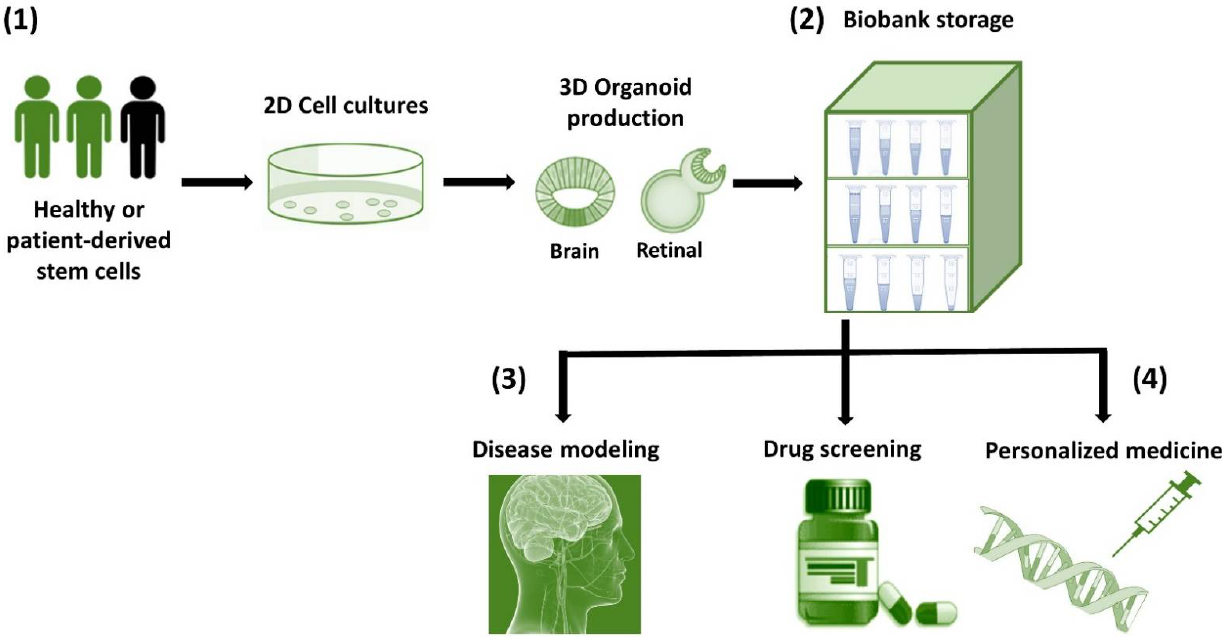
Figure 1. Schematic representation of the workflow from the production of brain and retinal organoids to their possible conservation/biobanking and potential applications. (1) Healthy or patient-derived stem cells differentiate and produce brain and retinal 3D organoids. (2) Biobanking, whereby samples obtained from patients can be used to store patient-generated organoids as a resource for future research. (3) Disease modeling, to understand the mechanisms of human diseases such as neuronal disorders and retinal degeneration through various laboratory techniques. (4) Drug screening and personalized medicine, in which patient-derived organoids can be used to predict drugs response and as resources for regenerative medicine coupled with genetic